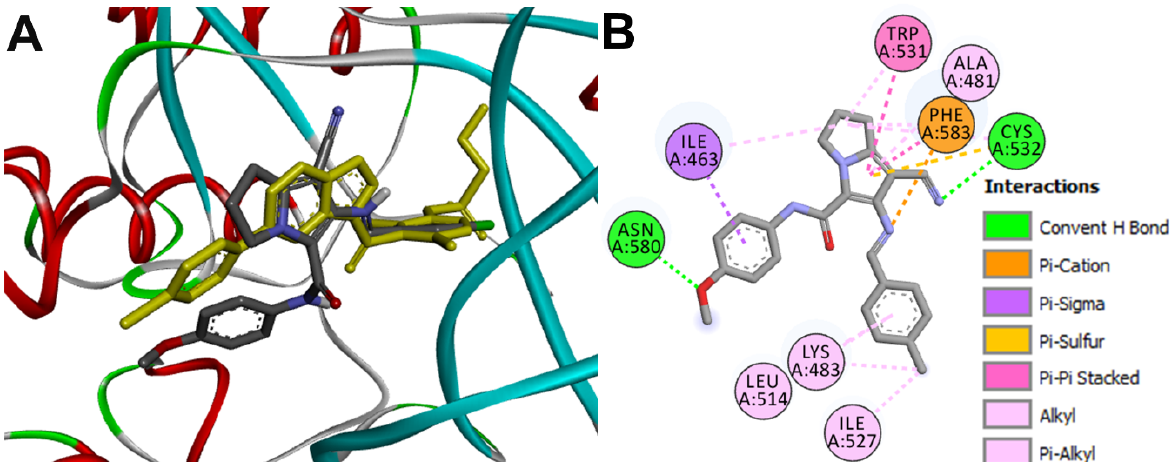
Figure 20. Binding mode of compound 16g (shown as sticks colored by element) into BRAF (pdb: 4RZV): ( A ) 3D binding mode of best-ranked pose of 16g overlaid with the co-crystallized ligand, vemurafenib (shown as yellow sticks); ( B ) 2D binding mode of 16g showing different types of interactions with amino acids BRAF.